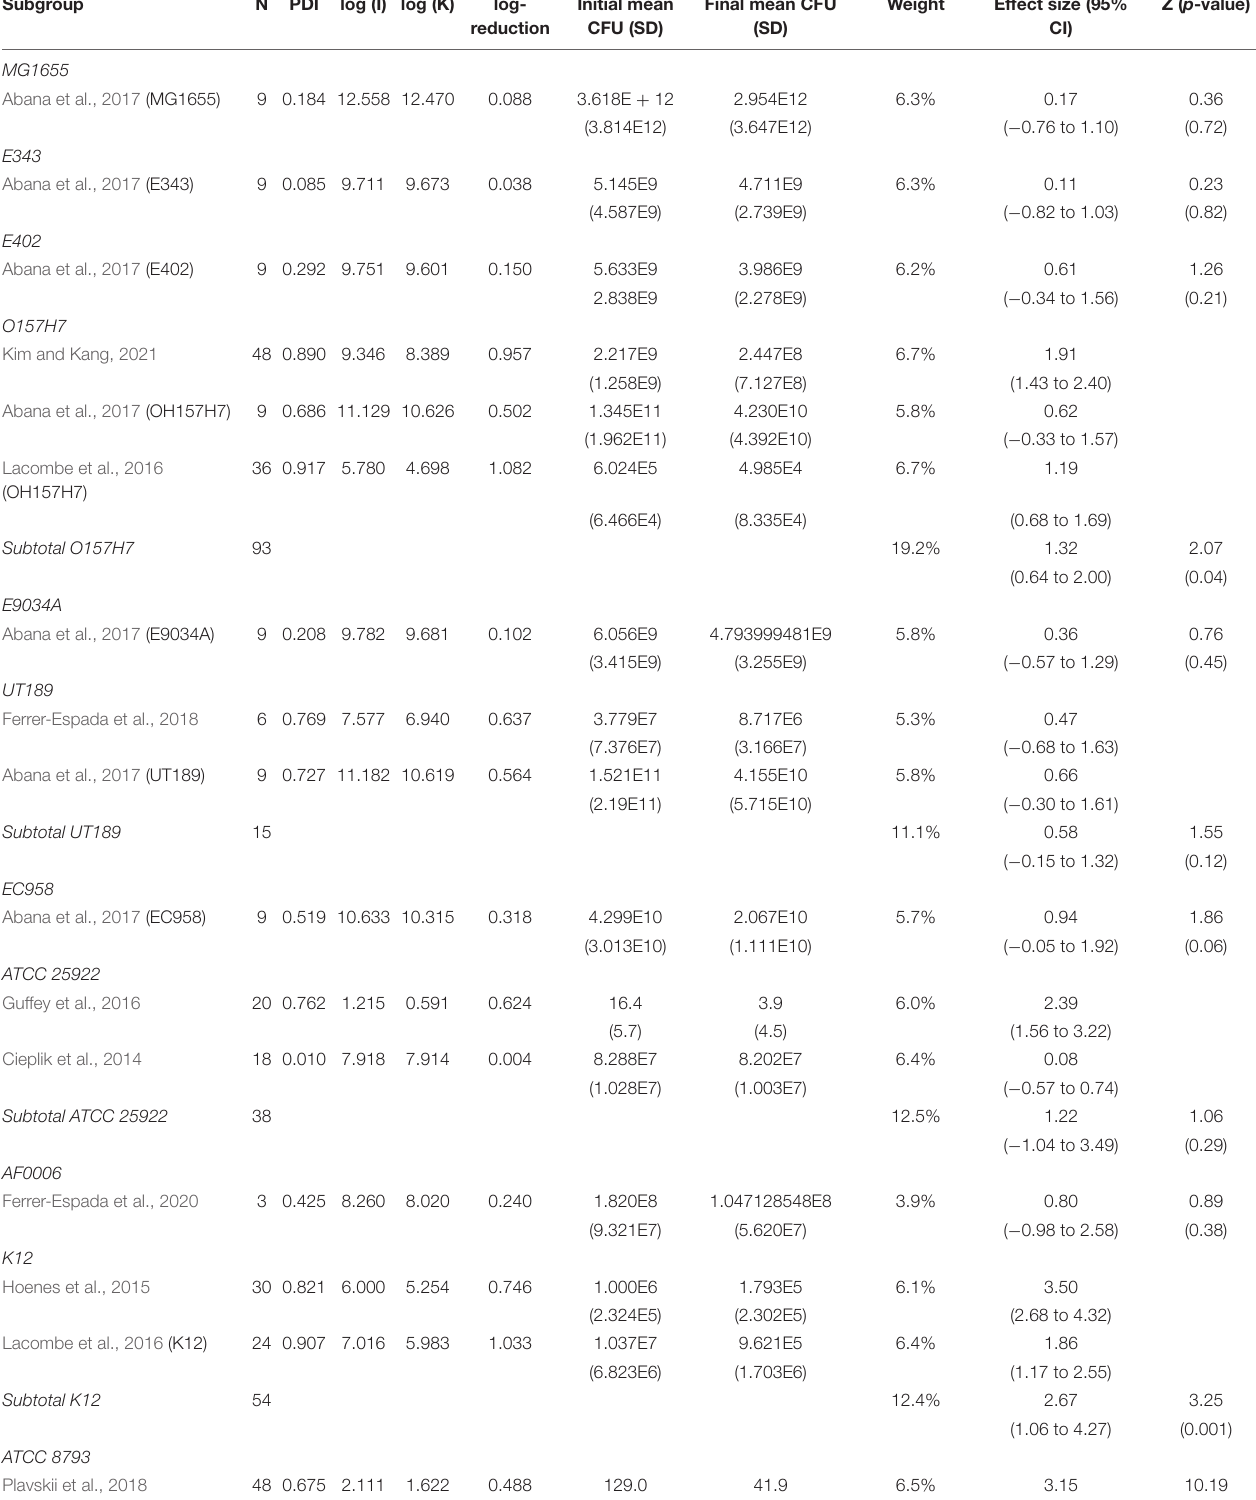
TABLE 6 | CFU E. coli outcomes by serovar/pathovar.